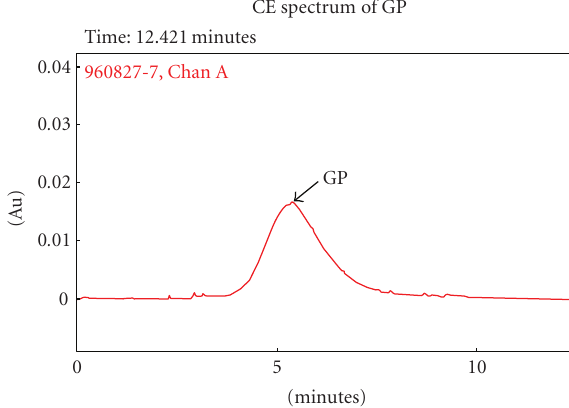
Figure 3: Capillary electrophoresis (CE) analysis of GP. The spectra showed that the purity of GP was greater than 95%. Table 2: Biodistribution of FDG in breast tumor-bearing rats. %